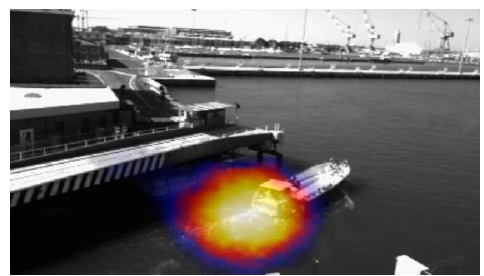
Figure 2. Image produced by an acoustic camera in the port of Livorno.